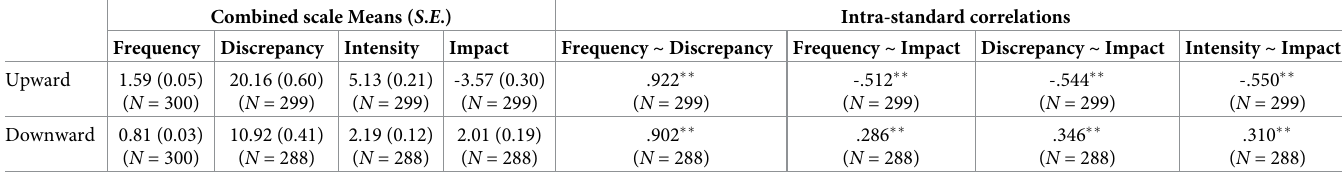
Table 3. Means, standard errors, intra-standard correlations per comparison direction for frequency, discrepancy, intensity, and impact scores. Combined scale Means ( S . E